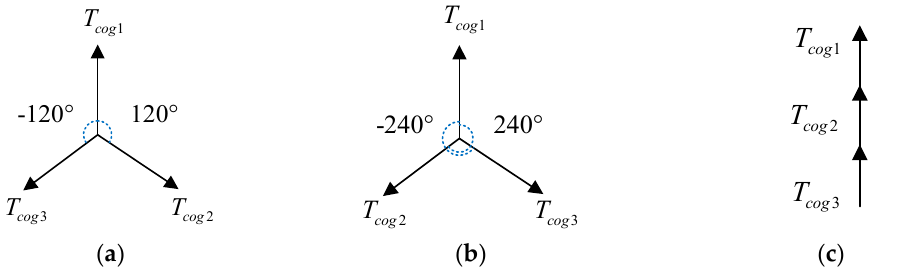
Figure 9. Cogging torque phasor diagram for equal angle: ( a ) N non orders ( b ) 2 N non orders ( c ) 3 N non orders.